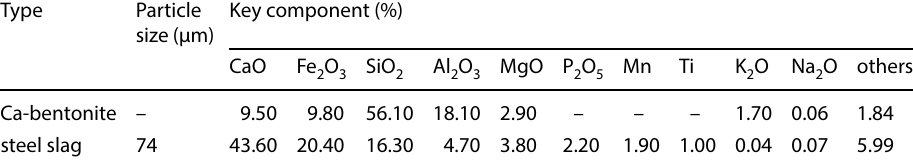
Table 3 The data of bentonite and steel slag